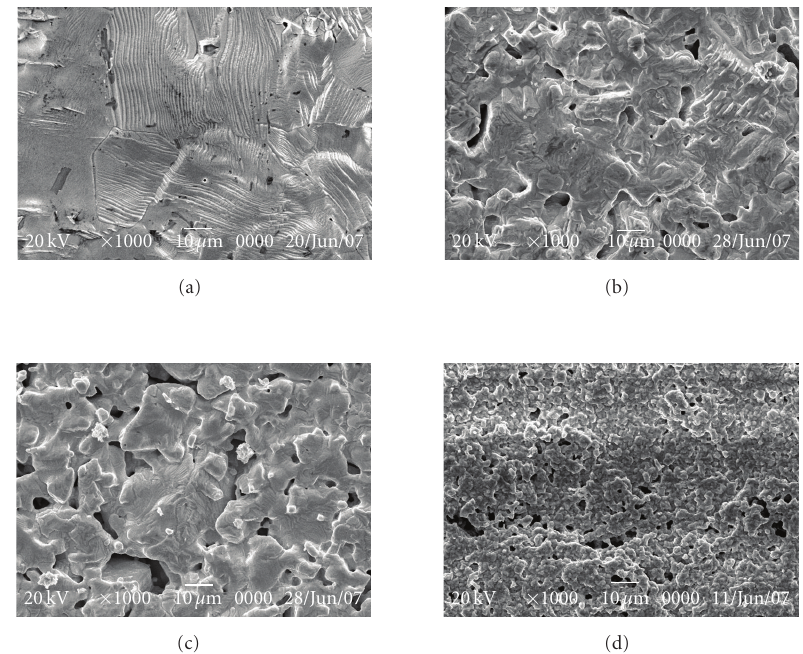
Figure 2: SEM images of as-sintered samples: (a) BaBiO 3 , (b) BaBi 0 . 99 La 0 . 01 O 3 , (c) BaBi 0 . 97 La 0 . 03 O 3 , and (d) BaBi 0 . 90 La 0 . 10 O 3 .